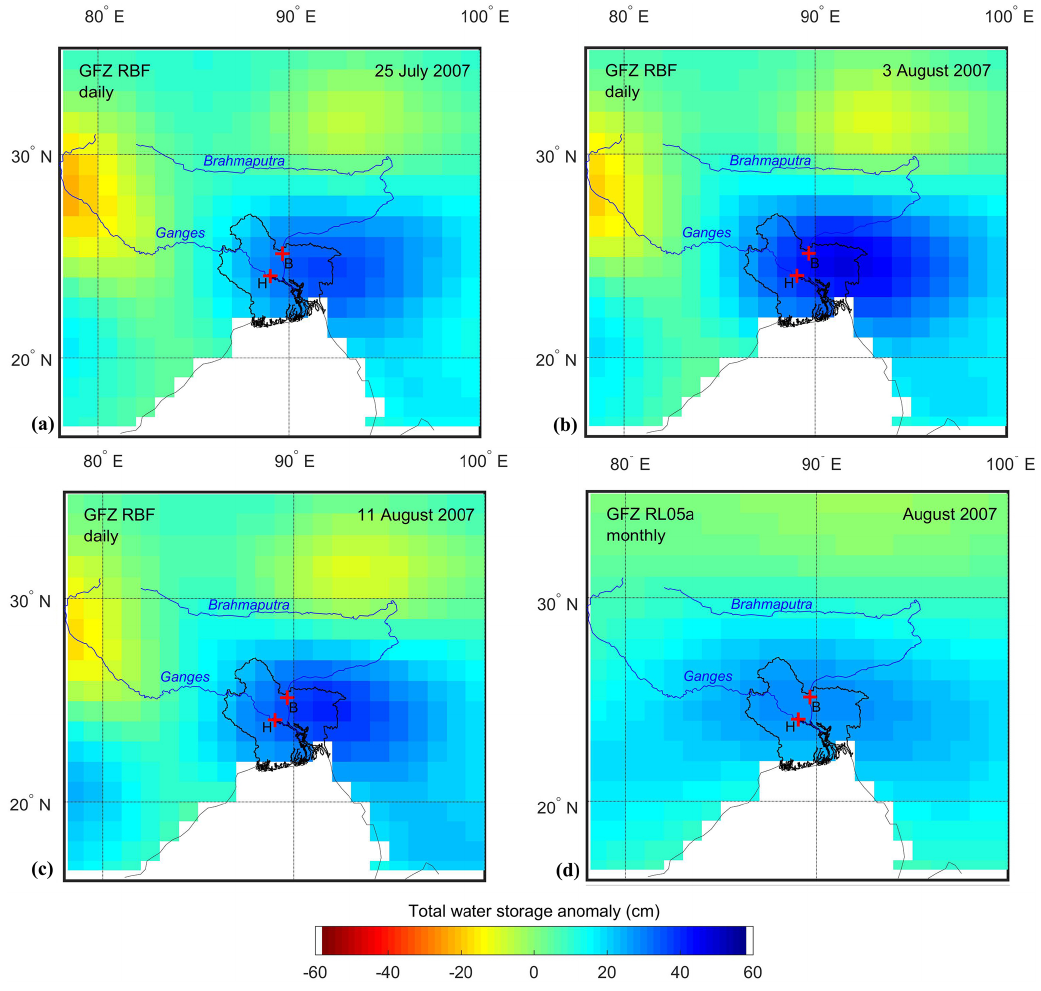
Figure 6. Daily and monthly water storage anomalies of the GFZ RBF solution for the Ganges–Brahmaputra Delta on (a) 25 July 2007, (b) 3 August 2007, (c) 11 August 2007 and (d) August 2007. Key is as in Fig.